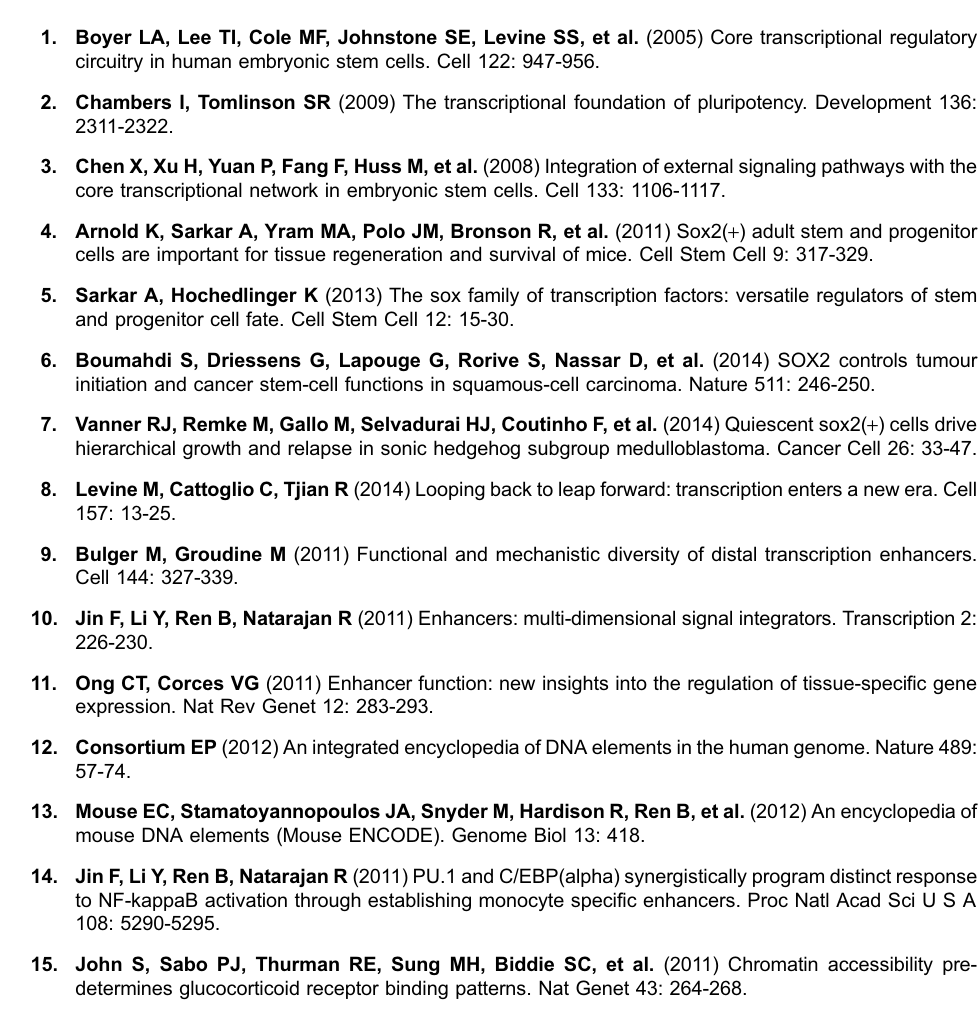
S2 Table . A list of 136 genes upregulated after deleting Sox2 enhancer. S3 Table . A list of 142 genes downregulated after deleting Sox2 enhancer. S4 Table . A list of genes bound by Sox2 at